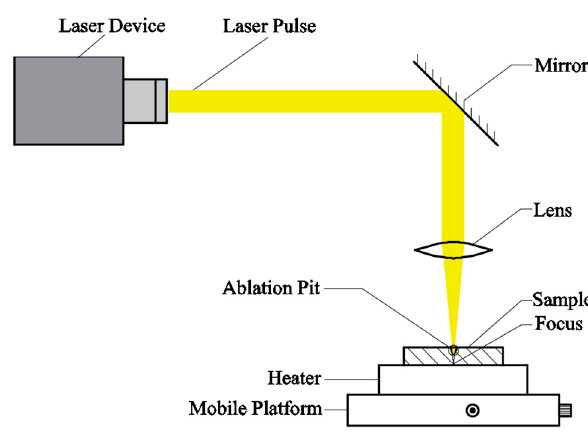
Table 2. Laser parameters of experiment.